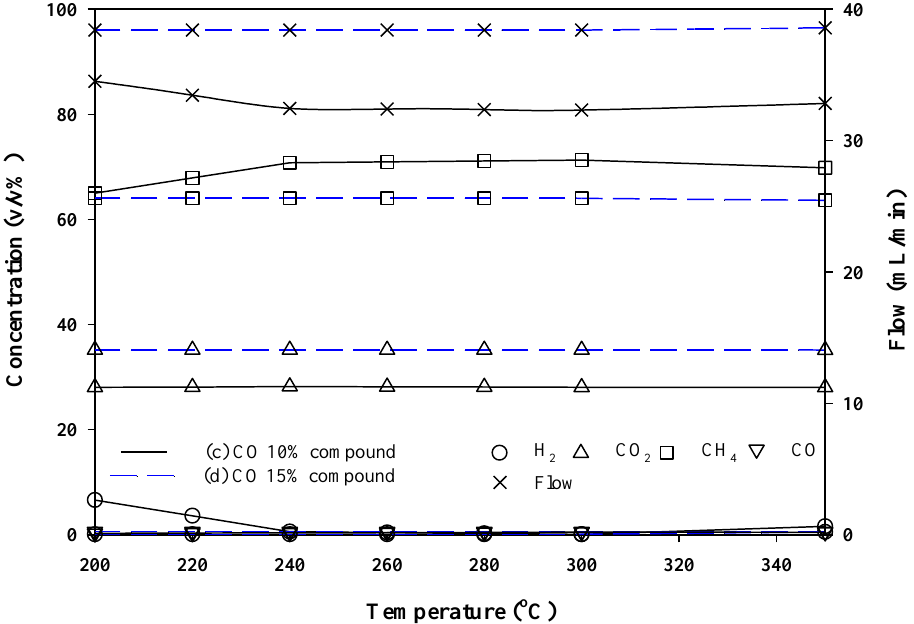
Figure 6. The composition of gases produced according to CO gas concentration (0 – 15%) in the CO 2 methanation reaction (2): (c) with CO 10% (d) with CO 15% (Total inlet gas 120 mL/min).